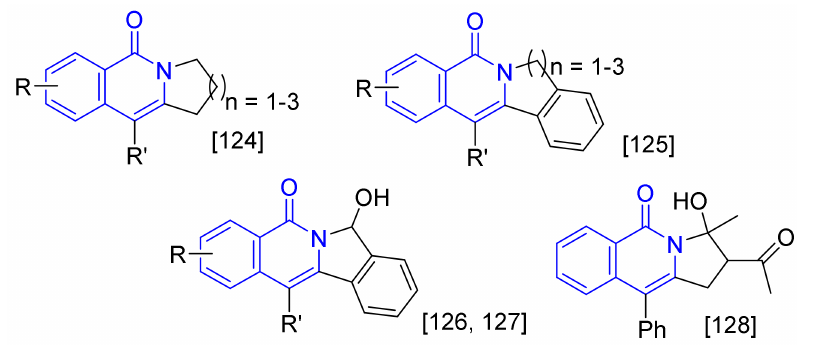
Figure 2. Polycyclic fused